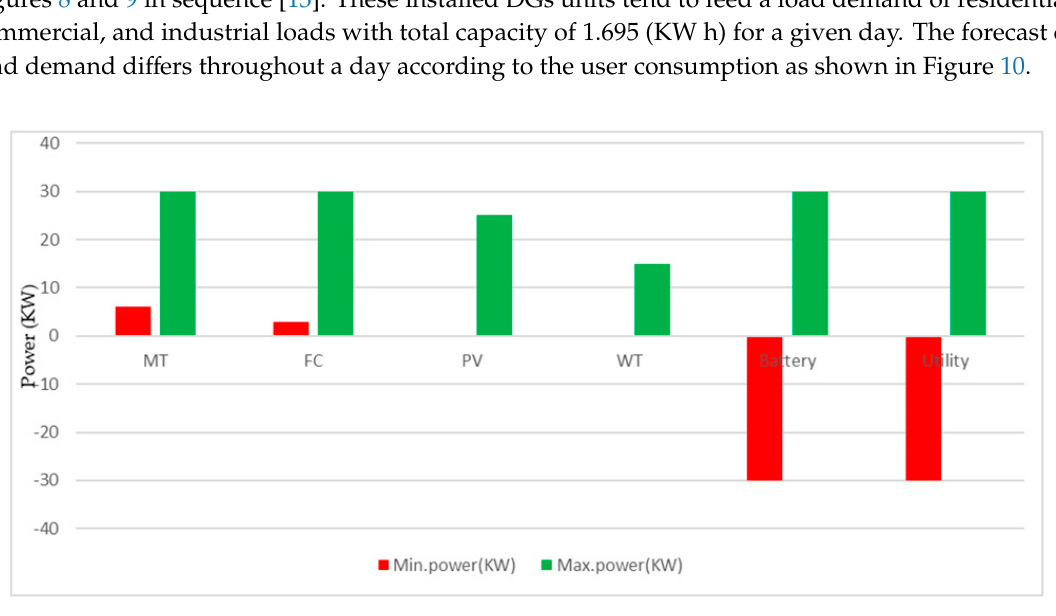
Figure 9. The bid degrees of the installed distributed generators.